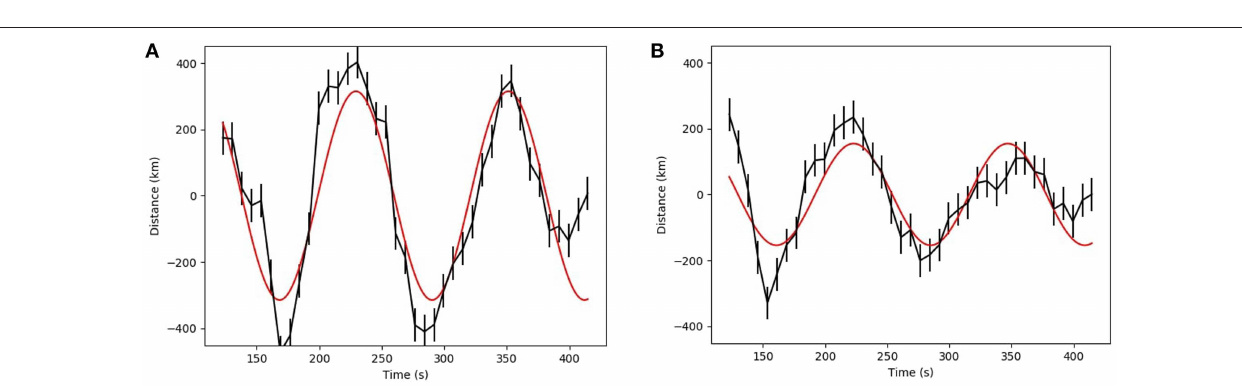
FIGURE 6 | (A) Top and (B) bottom boundary positions along the averaged slits given in Figure 5A (black line), detrended with a cubic polynomial. The error bounds on each point are the pixel size and therefore correspond to the error in the observations rather than the error in the trend fitting so represent a lower bound on the total error. The boundaries are fitted with a sinusoid (red